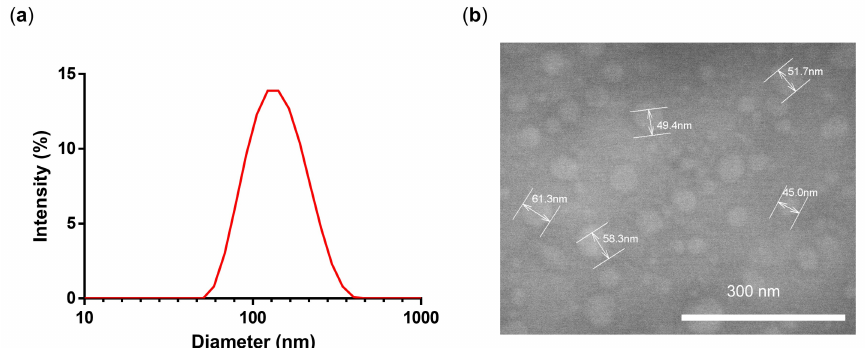
Figure 5. ( a ) DLS intensity size distribution and ( b ) TEM of